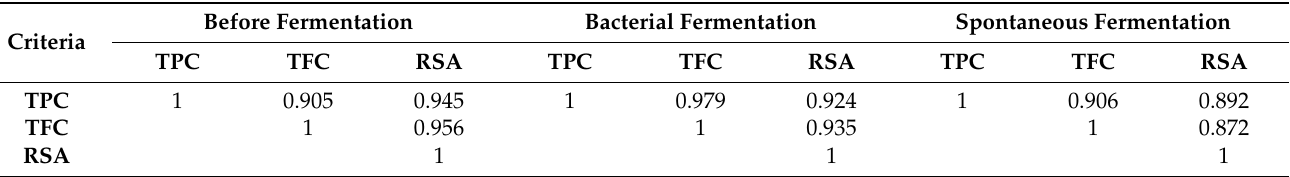
Table 6. Correlation coefficients between total phenolic compounds content (TPC), total flavonoid content (TFC), and radical scavenging activity